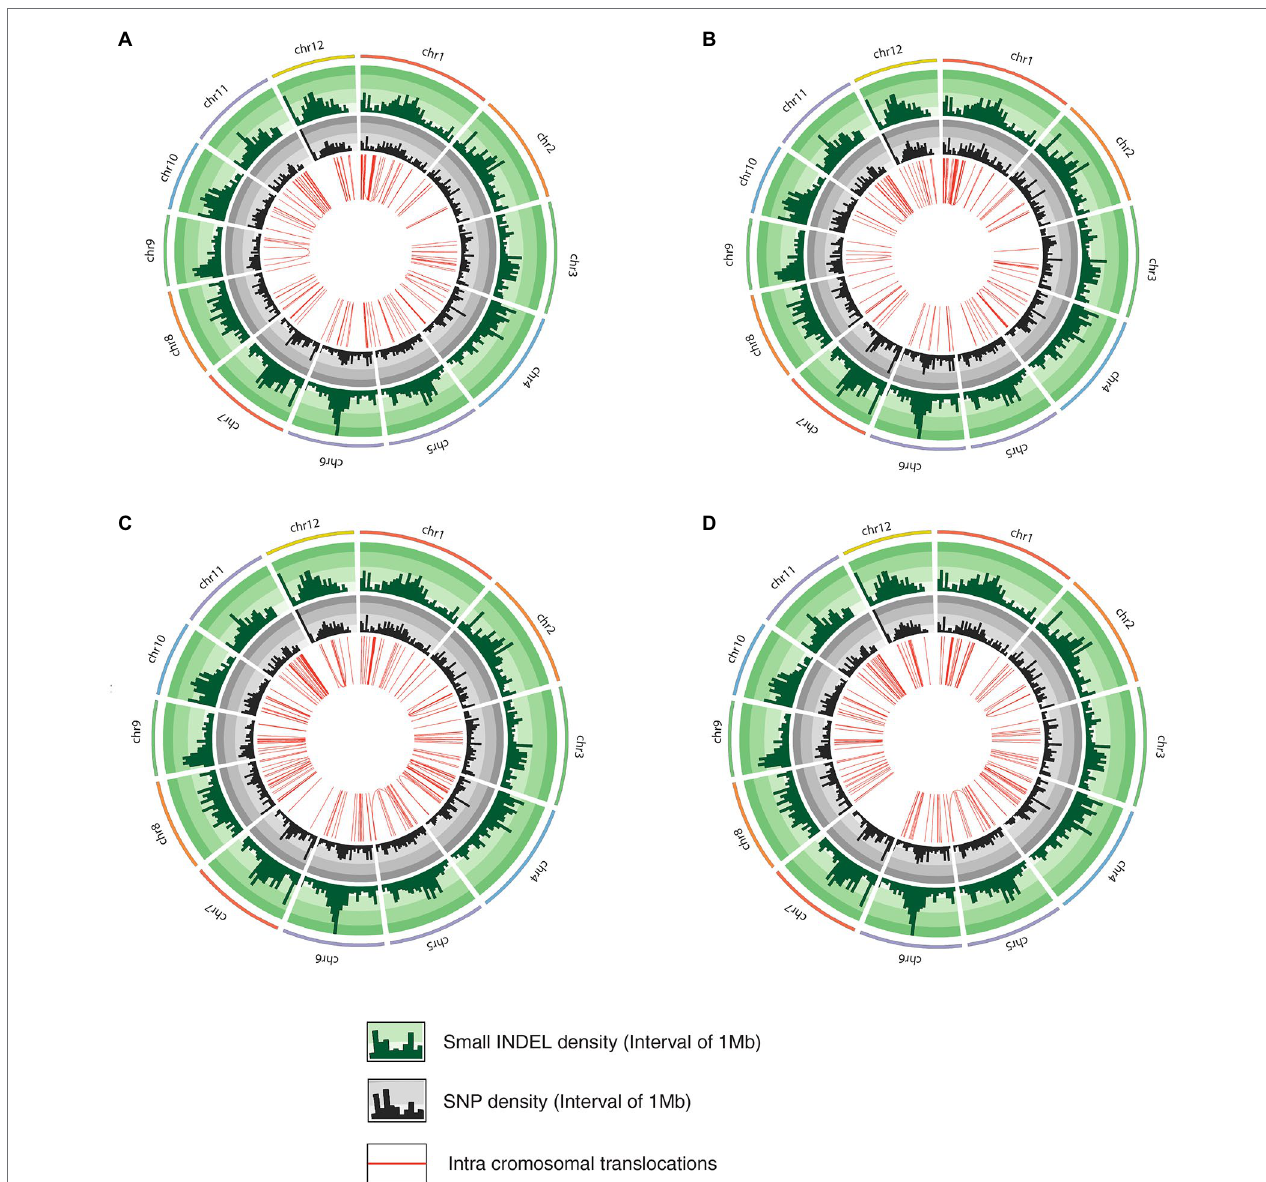
FIGURE 3 | Circos diagram representing genetic variation in mutant rice lines compared to JBT 36/14 genome depicting InDel density, SNP density and intrachromosomal translocations; (A) line-8, (B) line-9; (C) line-11, and (D)